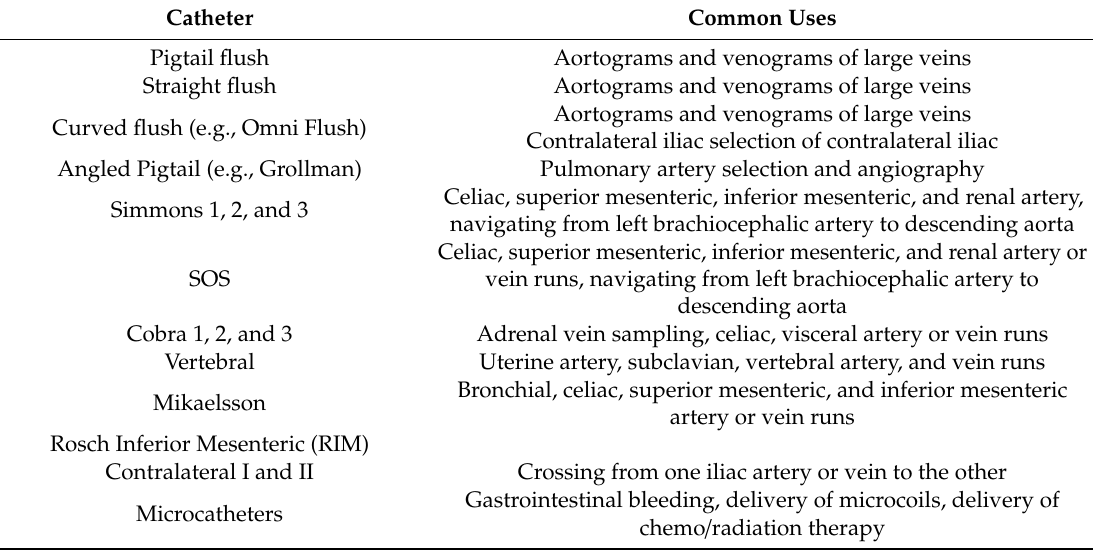
Table 2. Commonly used catheters, along with their